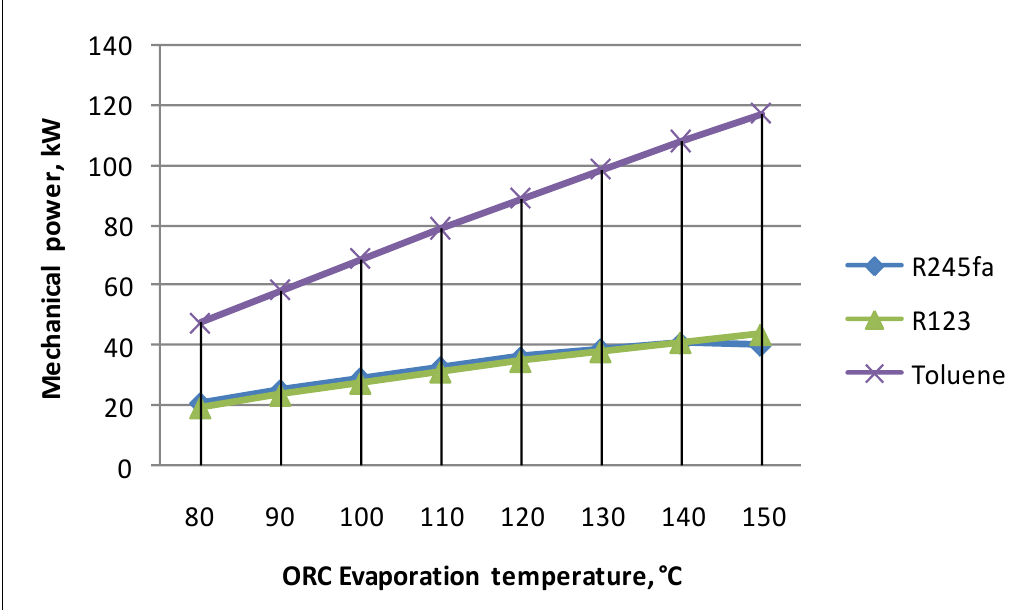
Figure 2. Variation of mechanical power of Turbine with ORC evaporation temperature according to the studied working fluids